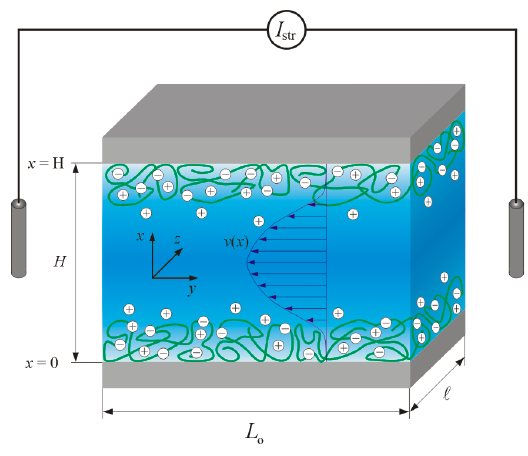
Figure 1. Schematic representation of a rectangular streaming channel for the characterization of soft polymer films supported by hard planar substrates from streaming current/potential measurements. The hydrodynamic flow field, v ( x ), developing in the channel under a lateral pressure gradient is indicated. The dimensions of the channel and polymer film are not shown to scale. For the sake of simplicity, charges located at the carrier surface are not represented. The scheme further details the nomenclature used in the theory reviewed in Section 2. Typical dimensions of the cell are: L o = 20 mm, (cid:96) = 10 mm and H = 5 µ m to 60 µ m. Reprinted from [11]. Copyright 2013 with permission from